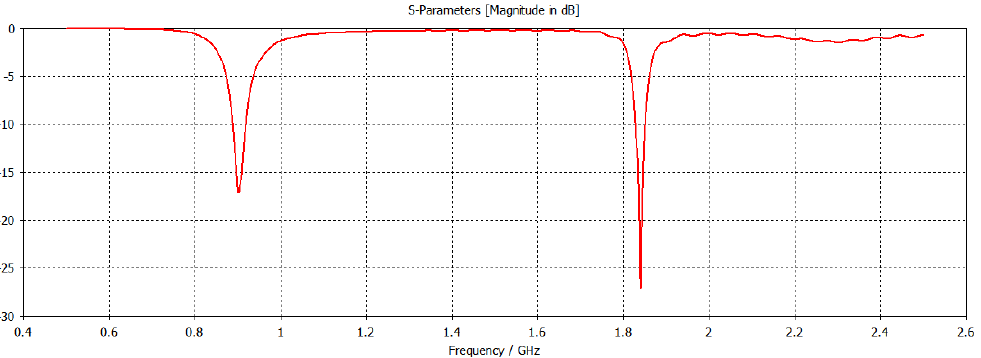
Figure 21. The return loss of antenna with head and